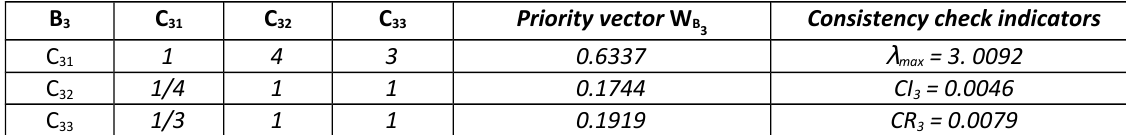
and its consistency check 3